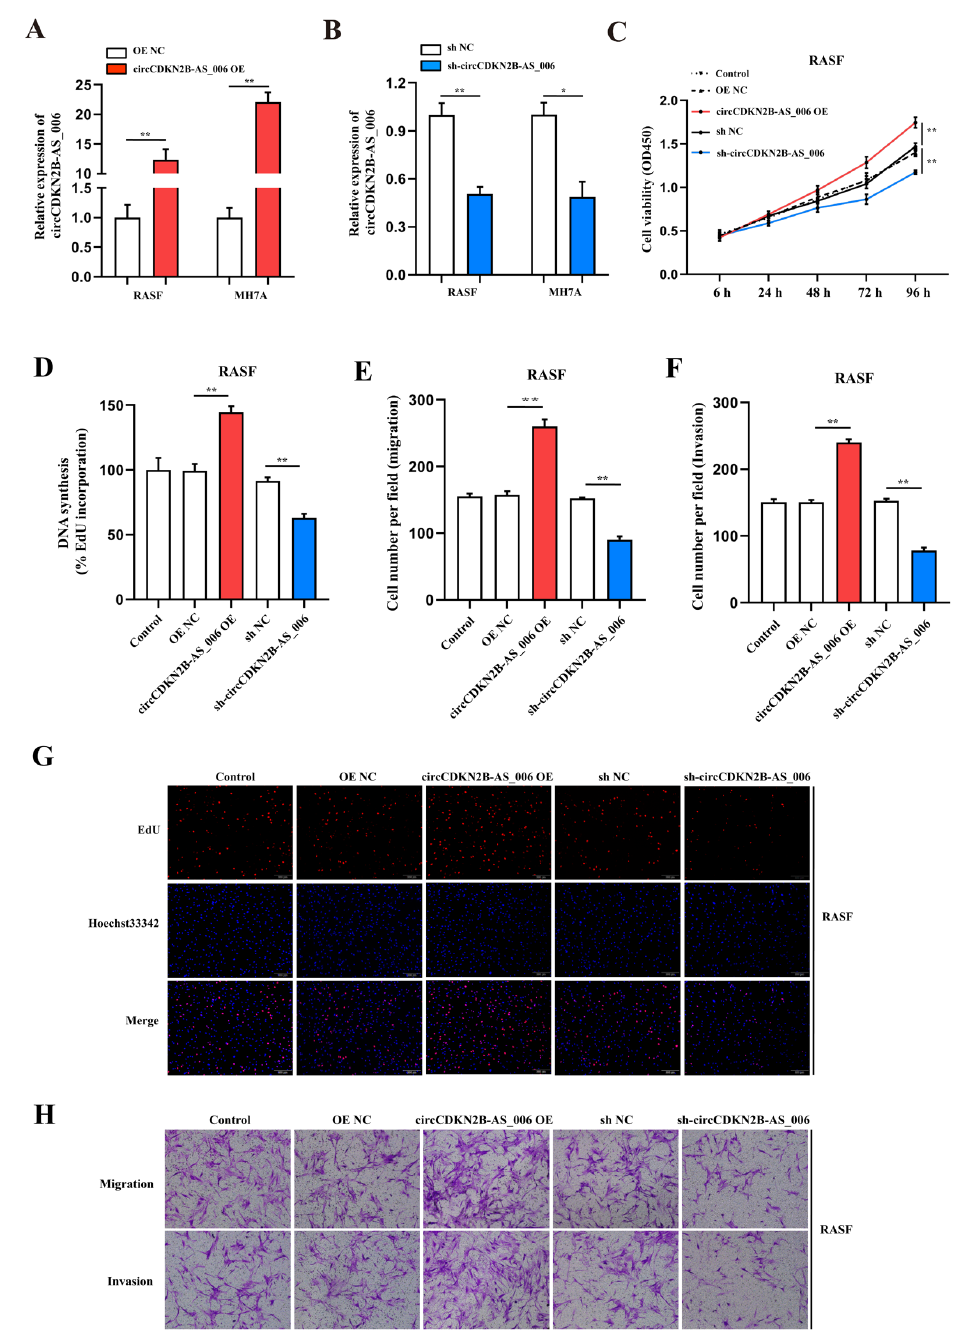
Figure 2. CircCDKN2B−AS_006 promotes the proliferation, migration, and invasion of RASFs in vitro. ( A , B ) The efficiency of circCDKN2B−AS_006 overexpression ( A ) and silencing ( B ) in RASFs and MH7A cells was verified by means of RT−qPCR. ( C ) The growth curves of RASFs with circCDKN2B−AS_006 knockdown and overexpression were monitored via CCK−8 assays. ( D , G ) EdU assays show that knockdown of circCDKN2B−AS_006 inhibited the DNA synthesis of RASFs, whereas the overexpression of circCDKN2B−AS_006 promoted DNA synthesis in RASFs. ( E , F , H ) The cell migration and invasion abilities of RASFs were assessed via transwell assays. The samples were imaged at 100 × magnification. ** p < 0.01, * p < 0.05.